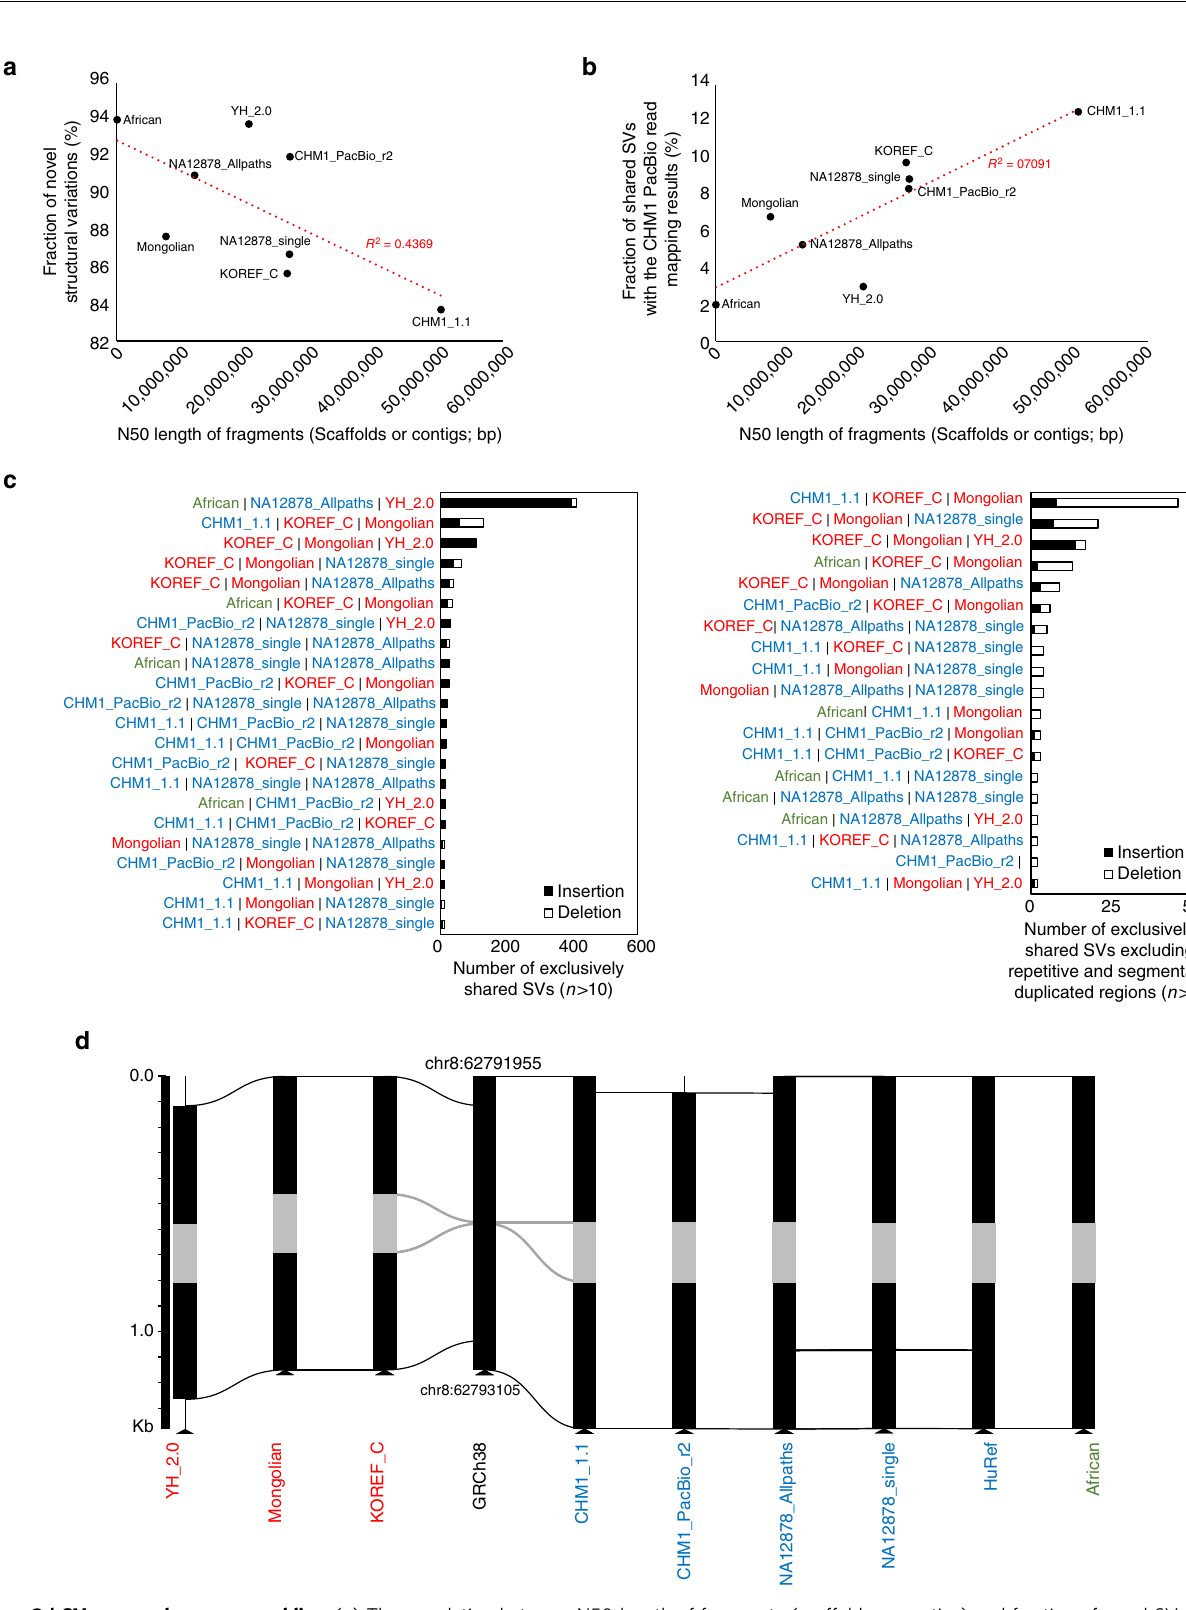
Figure 2 | SVs among human assemblies. ( a ) The correlation between N50 length of fragments (scaffolds or contigs) and fraction of novel SVs. ( b ) The correlation between N50 length of fragments and fraction of SVs shared with the CHM1 PacBio read mapping method. ( c ) Exclusively shared SVs among human assembly sets. SVs shared (reciprocally 50% covered) by only denoted assemblies were considered in this figure. ( d ) An example of SV that was shared by nine human assemblies. Grey regions denote structural differences shared among all the assemblies, and horizontal lines indicate homologous sequence